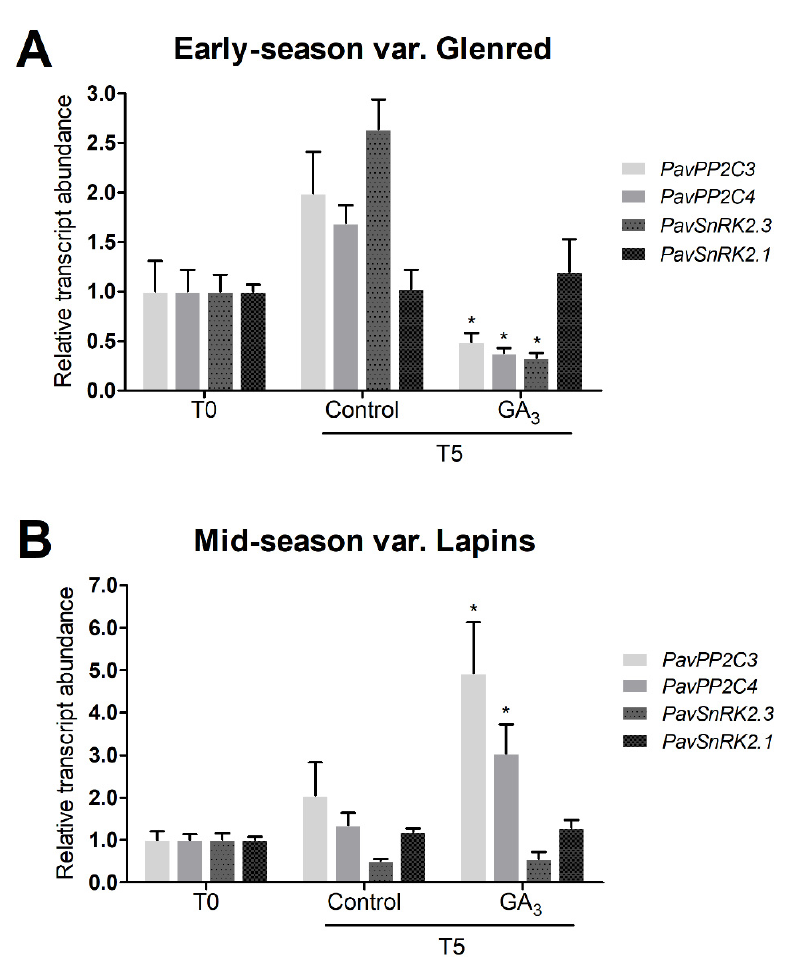
Figure 5. E ff ect of GA 3 on transcript abundance relative to PavCAC of PavPP2C and PavSnRK2 sweet cherry orthologs, 5 days after the treatment (T5). Fruits from control and GA 3 trees of ( A ) early-season variety Glenred and ( B ) mid-season variety Lapins were randomly selected and pooled for the RT–qPCR analyses. Data as + SEM. Relative transcript abundance was set to 1.0 at T0, where T0 is the sampling performed immediately before GA 3 application ANOVA with Tukey’s post hoc test at p < 0.05 was conducted; “*” denotes statistical di ff erences between GA 3 -treated and control fruits for a gene.